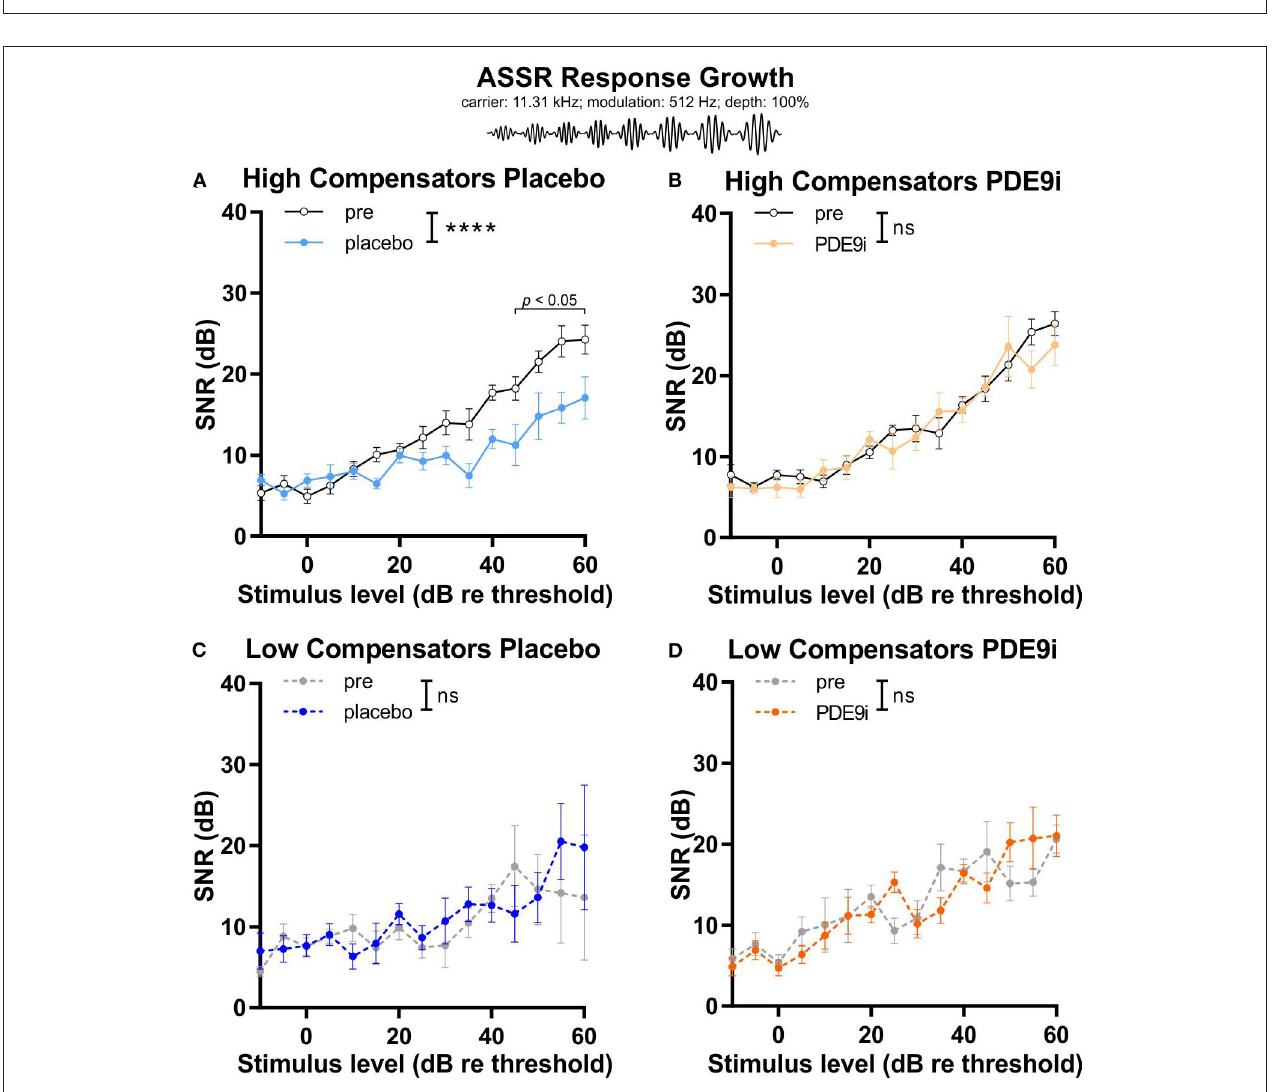
FIGURE 5 | Input–output relationship of auditory steady state responses (carrier frequency: 11.32kHz; modulation frequency: 512Hz; modulation depth: 100%) in high and low compensators treated with either placebo or PDE9i. (A) High compensators also showed a significant decrease of temporal auditory resolution after treatment with placebo. (B) However, in high compensators treated with PDE9i, this decrease was not present. Low compensators showed no change in temporal auditory resolution after treatment with either (C) placebo or (D) PDE9i. Mean ± SEM. ns p > 0.1, **** p < 0.0001, repeated measures 2-way ANOVA.